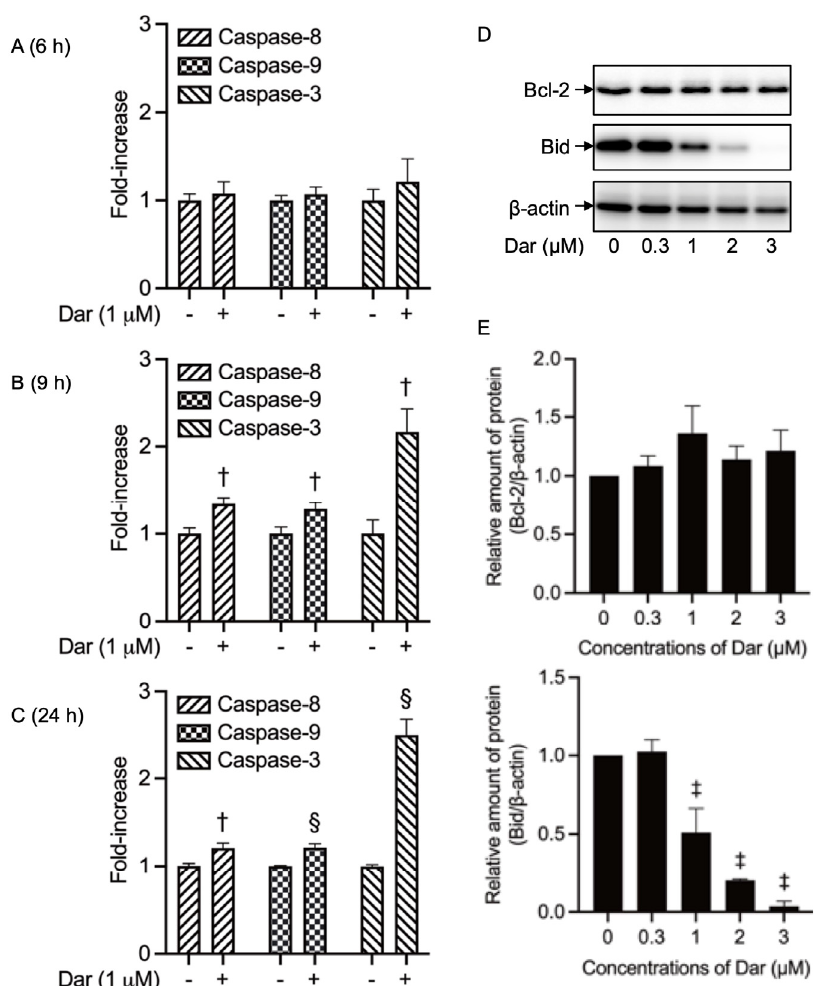
Figure 3. Caspase activation associated with Bid truncation in NB4 cells treated with darinaparsin. Following treatment with 1 μ M darinaparsin for 6 h ( A ), 9 h ( B ) and 24 h ( C ). The activities of caspase ‐ 8, ‐ 9, and ‐ 3 were measured using a caspase fluorometric assay kit as described in the “Materials and Methods” section. After treatment with various concentrations of darinaparsin (0.3, 1, 2 and 3 μ M) for 24 h, the expression profiles of Bcl ‐ 2 and Bid were analyzed using Western blotting. Representative image of the expression profiles of the Bcl ‐ 2 and Bid proteins are shown from three independent experiments ( D ). The densitometry of protein bands was analyzed using a program, NIH ImageJ 1.53k. The relative expression levels were expressed as the ratios between each protein and β‐ actin protein expression levels and were compared with those of an untreated control group ( E ). Results are shown as the means ± SD from three independent experiments. †, p < 0.01; §, p < 0.001; ‡, p < 0.0001 vs. control. Dar, darinaparsin.